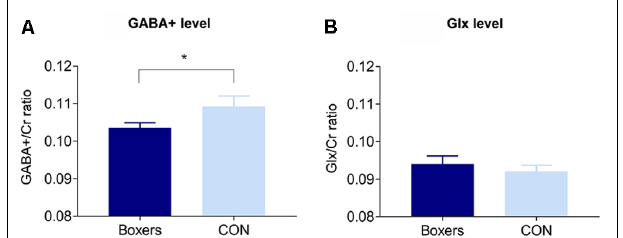
FIGURE 2 | Between-group differences in the GABA+/Cr and Glx/Cr in the PFC. (A) The GABA+/Cr was significantly lower in the Boxers group compared to the CON group ( z = − 2.21, permutation-adjusted P = 0.032). (B) There was no significant difference in the Glx/Cr between the Boxers and CON groups ( z = 0.88, permutation-adjusted P = 0.386). Error bars indicate standard errors. ∗ Indicates P < 0.05.